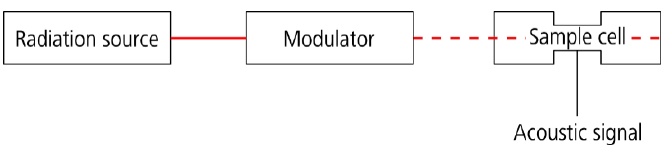
Figure 1. Schematic of a basic photoacoustic spectroscopy (PAS) setup.